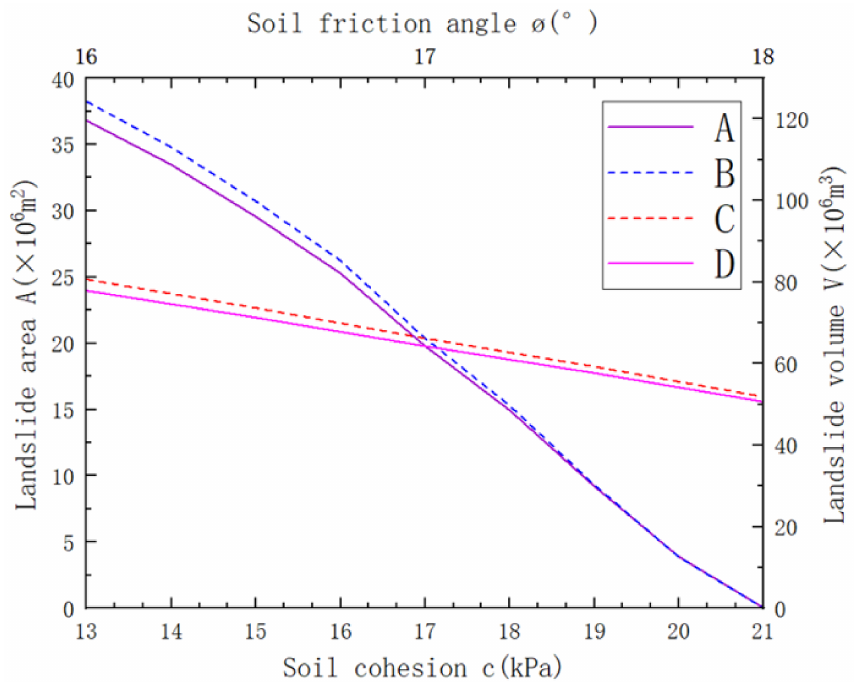
Figure 16. Sensitivity analysis results on friction angle and cohesion; ( A ) relationship curve between cohesion and landslide area; ( B ) relationship curve between cohesion and landslide volume; ( C ) rela- tionship curve between friction angle and landslide volume; ( D ) relationship curve between friction angle and landslide